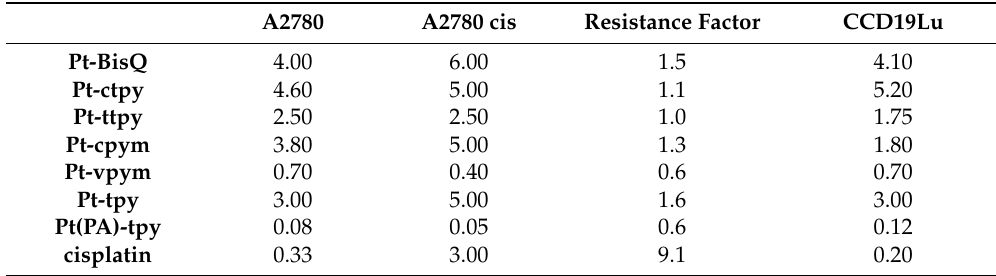
Table 2. The IC 50 ( µ M) of the various platinum complexes calculated from the proliferation of A2780, A2780cis, and CCD19Lu cell lines after 96 h treatments and their resistance factor (IC 50